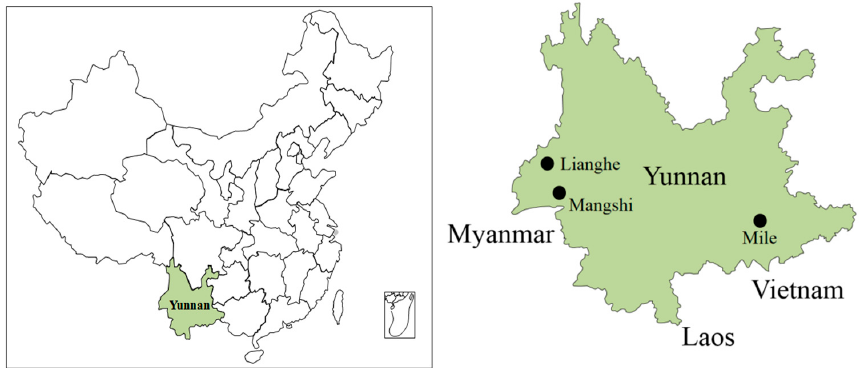
Figure 1. Specimen trapping sites in Yunnan Province, China.